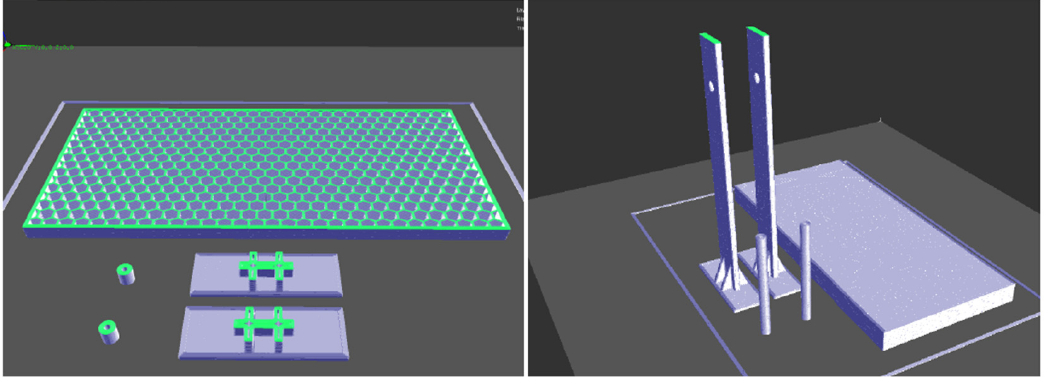
Figure 10. Three-dimensional printed model of the Transition sculpture.